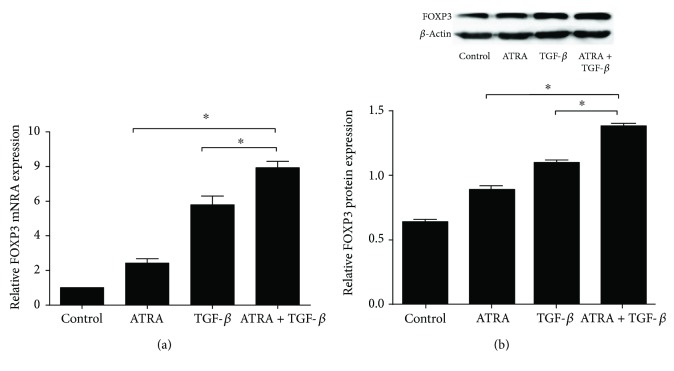
The expression of FOXP3 in SSc CD4+ T cells. FOXP3 mRNA and protein levels were analyzed by real-time quantitative PCR and Western blotting, respectively, in different cell groups. (a) The bar chart shows relative FOXP3 mRNA expression in ATRA-treated SSc CD4+ T cells normalized to β-actin. (b) The image shows the protein expression of FOXP3 and β-actin on the Western blots. The bar chart shows quantification of the Western blot band intensities of FOXP3 protein levels normalized to β-actin. FOXP3 mRNA and protein levels were increased in SSc CD4+ T cells stimulated with ATRA and/or TGF-β compared with the blank control group (all, p < 0.05). The ATRA and TGF-β combined stimulus group showed a significantly increased percentage of Tregs compared with the ATRA or TGF-β alone group (∗p < 0.05). Data are presented as the mean ± SD and are representative of at least 3 independent experiments.